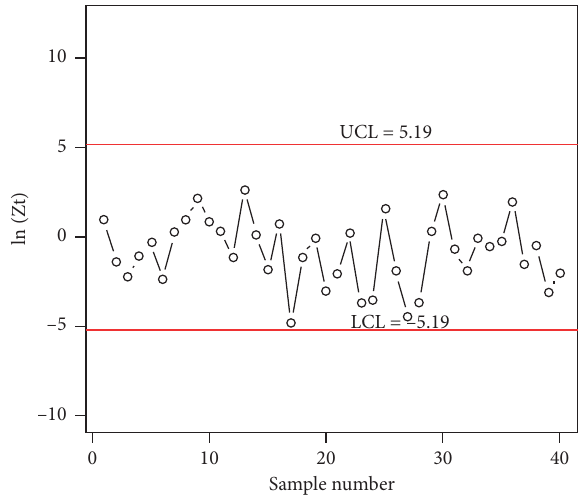
Figure 6: Shewhart chart for UTI